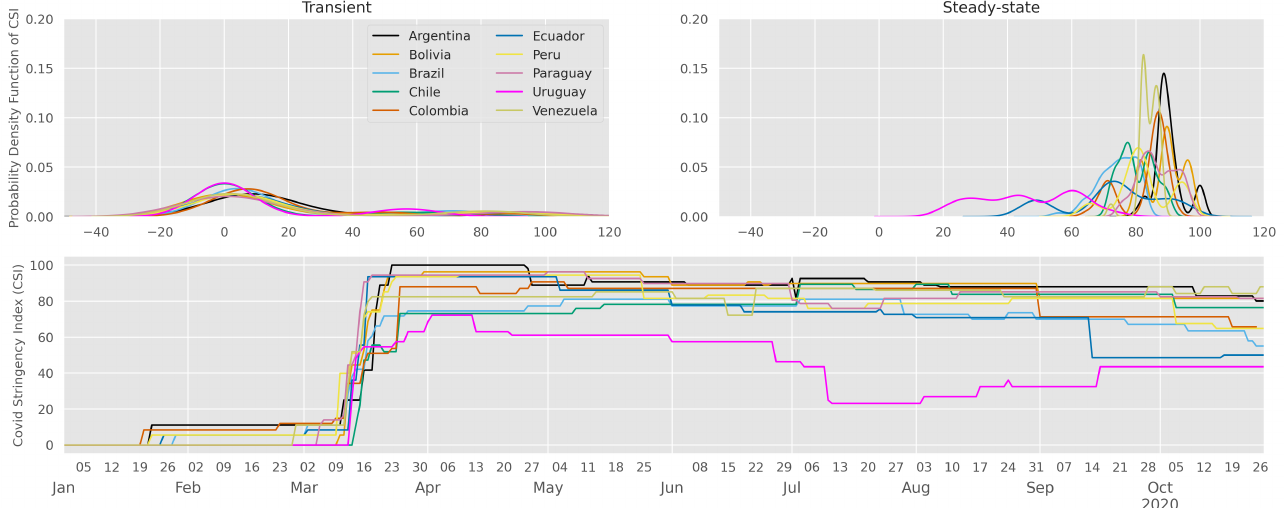
Figure 7. Probability density function (PDF) of the Covid stringency index: total, transient and steady-state periods. Source of basic data: Oxford Covid-19 Government Response Tracker